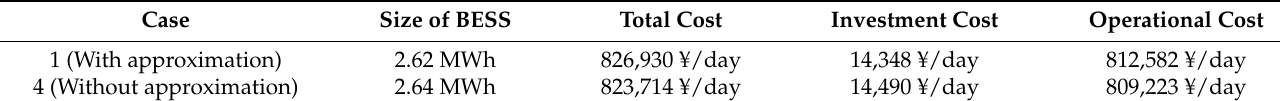
Figure 8. Obtained solution in Case 4 ( Q ∗ = 2.64 (MWh)): ( a ) operation schedule; ( b ) transition of SOC level. Table 3. Comparison of obtained solutions in Cases 1 and 4.